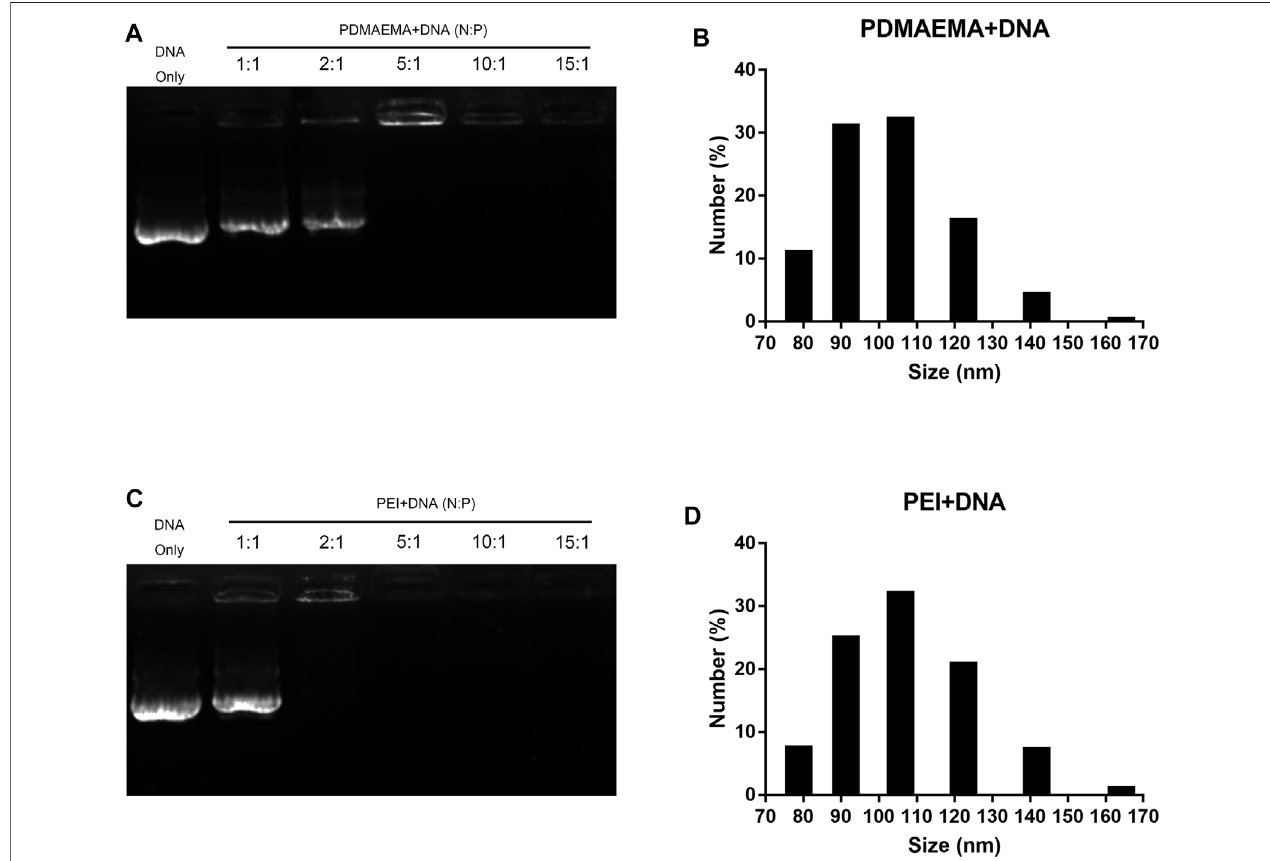
FIGURE1| CharacterizationofPDMAEMA+DNAandPEI+DNA. (A) GelretardationassayofPDMAEMA+DNA(1 μ g)atN/Pratiosof1:1,2:1,5:1,10:1,and15: 1. (B) Hydrodynamic diameter distributions of PDMAEMA + DNA (5 μ g) (N/P ratio 15) determined by dynamic light scattering. (C) Gel retardation assay of PEI + DNA (1 μ g) at N/P ratios of 1:1, 2:1, 5:1, 10:1, and 15:1. (D) Hydrodynamic diameter distributions of PEI + DNA (5 μ g) (N/P ratio 15) determined by dynamic light